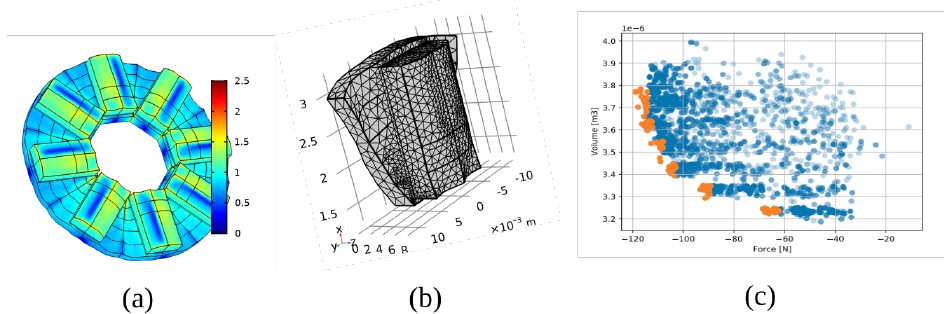
Figure 11. Example of design optimization and weight reduction of a 3D printed magnetic clutch with the ¯Artap framework: ( a ) magnetic flux density, ( b ) is the mesh and ( c ) is the Pareto